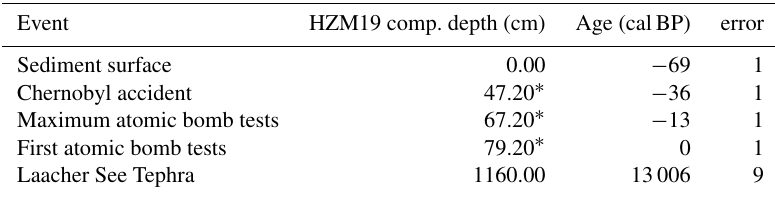
Table A7. Additional dates for the HZM19 chronology with composite depths, ages (calBP), and errors used for Bacon calculations. LST ages with error are from Reinig et al.